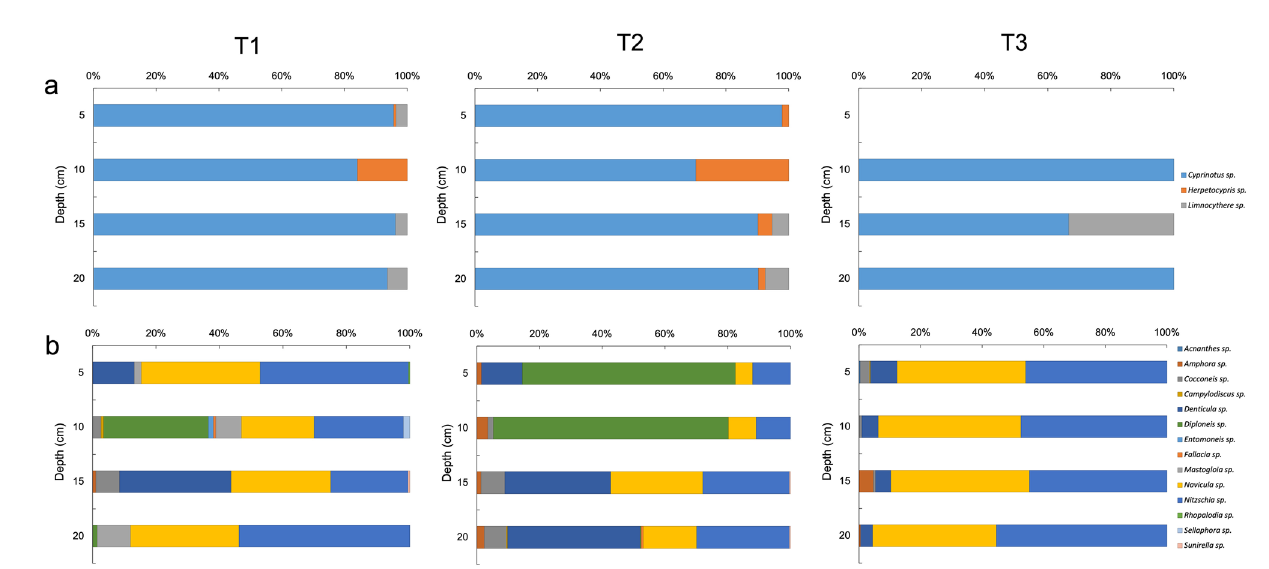
Figure 5. Relative abundance of diatoms and ostracods. ( a ) Percentual abundance of ostracods genera and ( b ) diatoms genera identified in sampling points in Salar de Tara T1, T2 and T3, through 20 cm depth